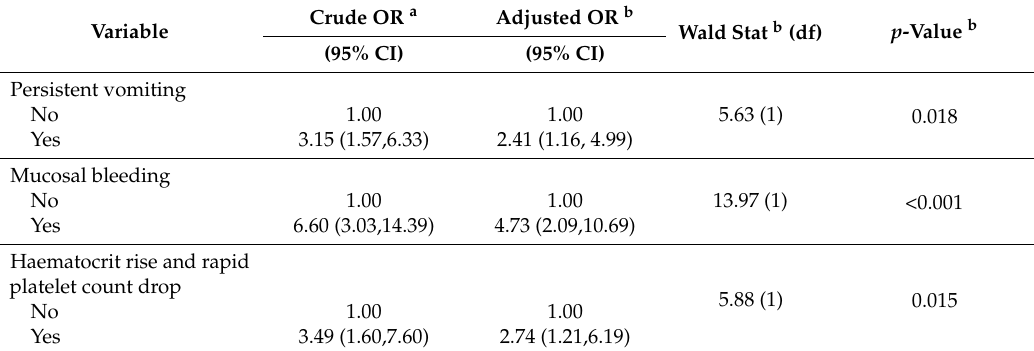
Table 7. Multiple logistic regression analysis of factors associated with SD.